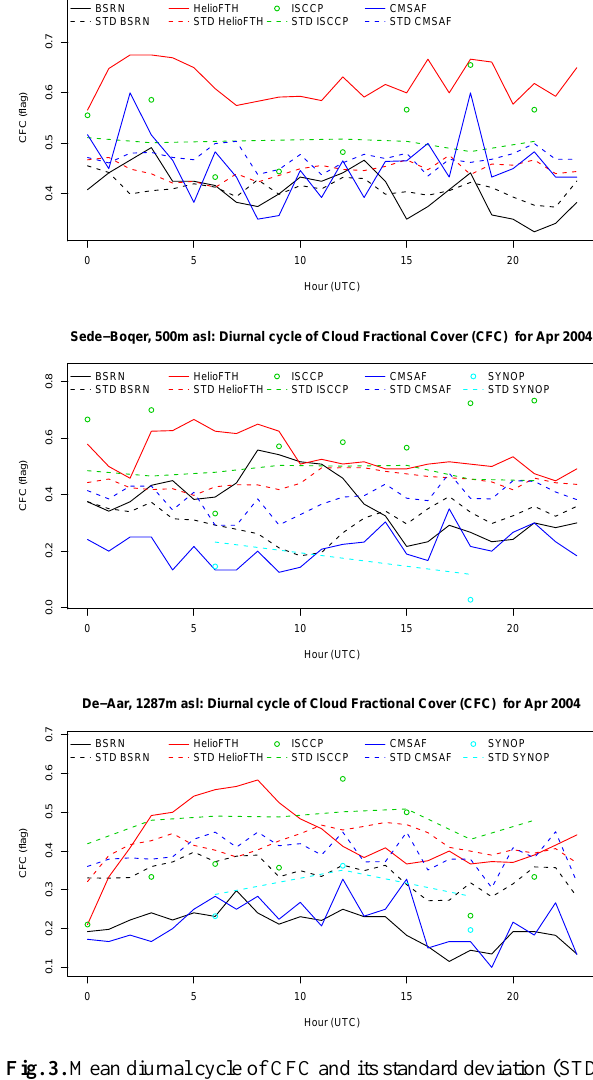
Table A1. Contingency table of satellite and synoptic / reference satellite (reference dataset) observations.